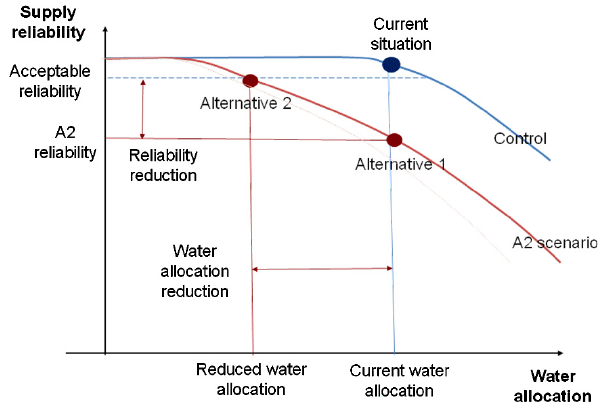
Fig. 2. Example of demand-reliability analysis in a basin for a given climate change